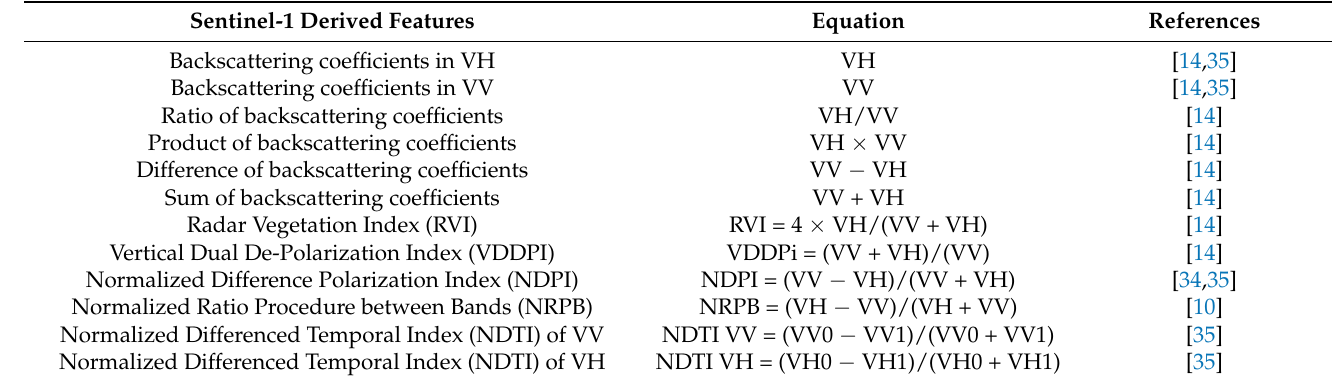
Table 1. Sentinel-1 indices derived from polarization